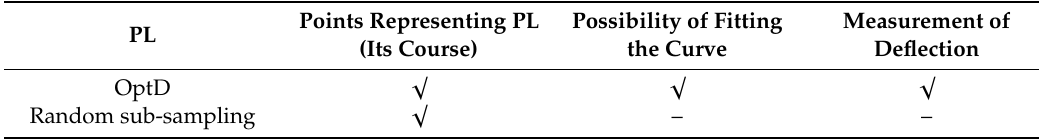
Table 11. Information about PL preserved after data